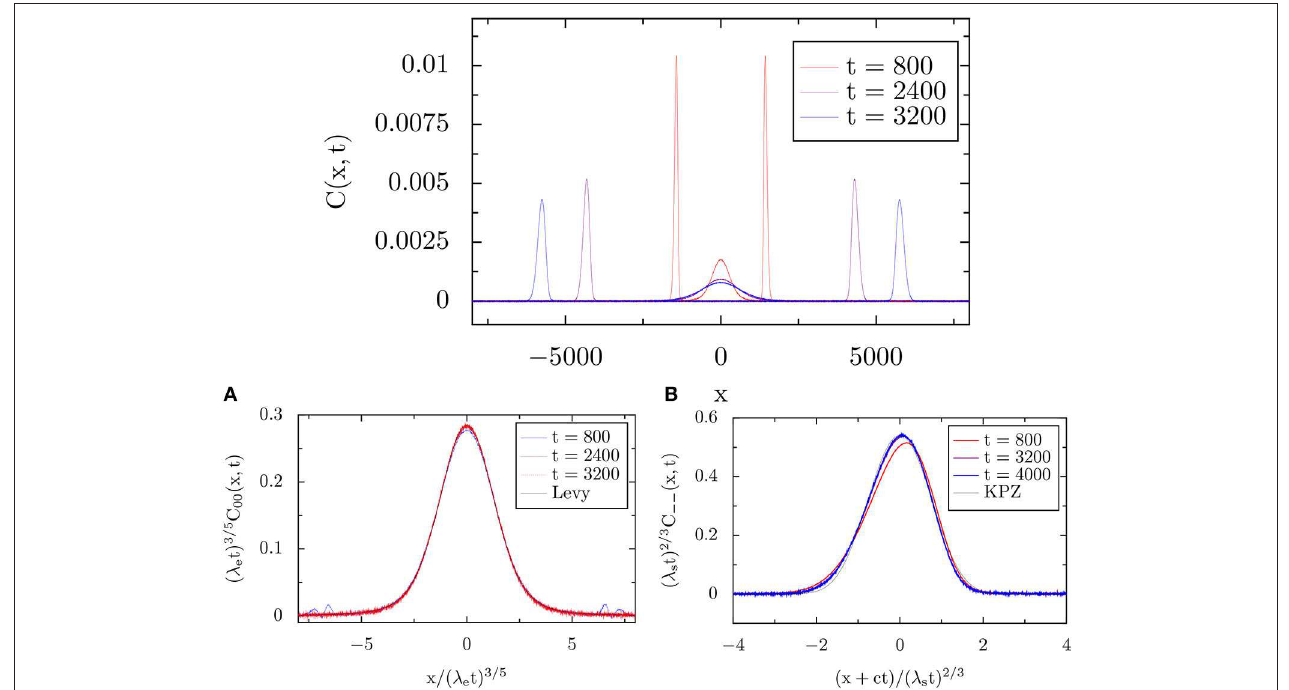
FIGURE 8 | (Top) Plots of the heat mode correlation C 00 ( x , t ) (central peaks) and the sound mode correlations C ( x , t ) and C ( x , t ) (right and left moving peaks) in ++ −− the FPUT chain, at three different times, for the parameter set with k 2 1.0, k 3 2.0, k 4 1.0, T 5.0, P 1.0, and system size 16,384. The speed of sound was = = = = = c 1.80293. We see that the heat and sound modes are well-separated. The numerical data in this plot were obtained by averaging over around 10 6 10 7 initial = − conditions. (Bottom) The heat mode (A) and the left moving sound mode (B) correlations, respectively, C 00 ( x , t ) by C ( x , t ) are plotted at different times, using a −− Lévy-type-scaling for the heat mode and KPZ-type scaling for the sound mode. Here we observe a very good collapse of the data at different times. Moreover, we observe a good fit to the Lévy-stable distribution with λ e 5.86 and a reasonable fit to the KPZ scaling function, with λ s 0.46. The parameters used in this plot are = = k 2 1.0, k 3 2.0, k 4 1.0, T 5.0, P 1.0 (adapted from Das et al. with permission from [63] Copyright (2014) by American Physical = = = = =